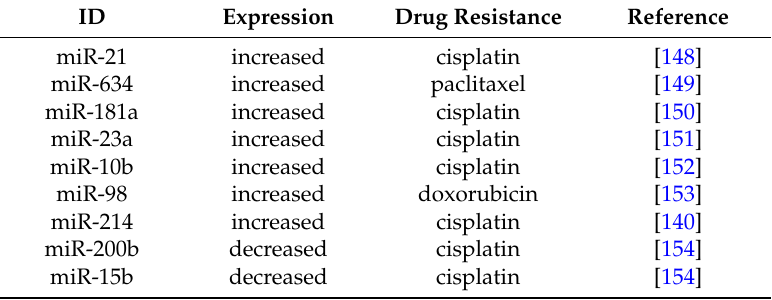
Table 2. Deregulation of miRNAs associated with chemoresistance in